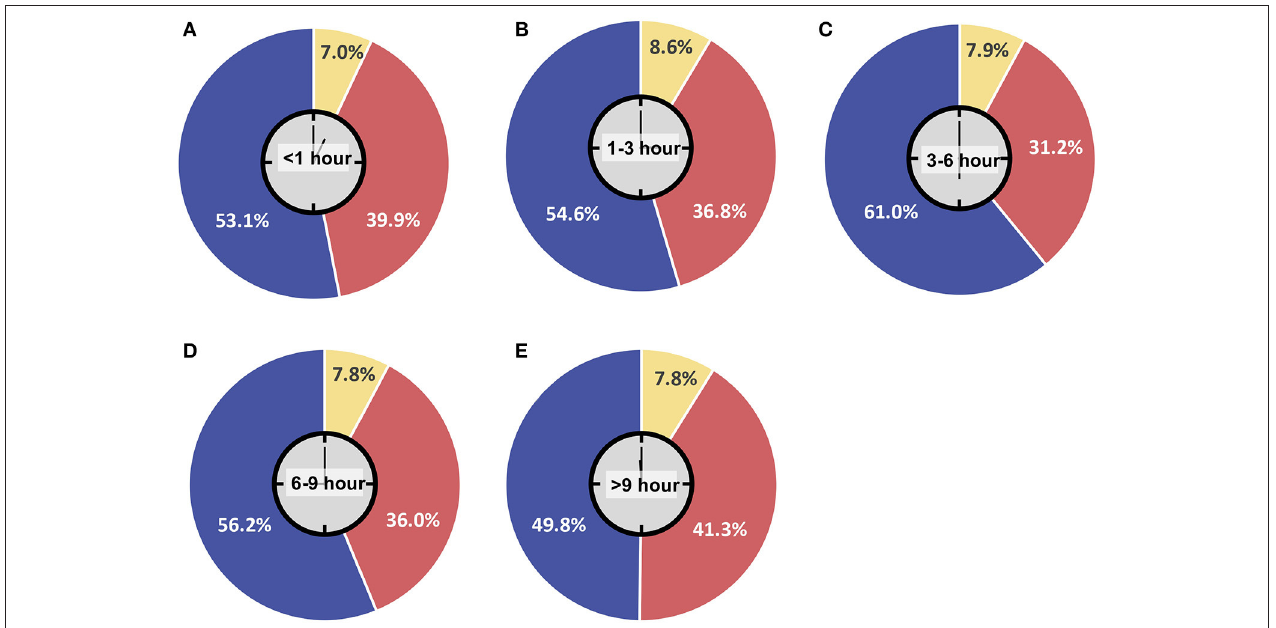
FIGURE 2 | Mask-wearing tolerance among respondents’ children. (A) Less than 1h; (B) 1–3h; (C) 3–6h; (D) 6–9h; (E) More than 9h.